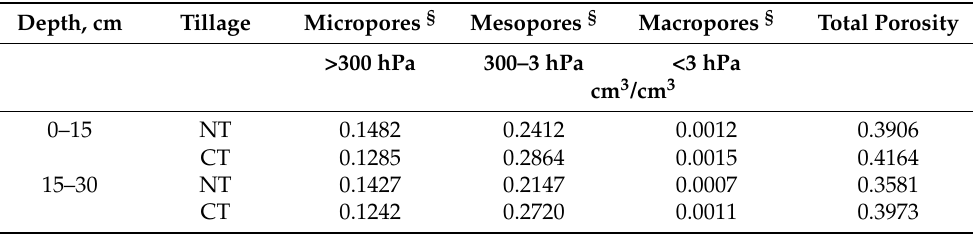
Table 3. Soil pore volume of macro-, meso-, and micro-pore classes of untilled (NT) and convention- ally tilled (CT) soils at 0–15 and 15–30 cm depths. Depth, cm Tillage Micropores § Mesopores § Macropores § Total Porosity >300 hPa 300–3 hPa <3 hPa cm 3 /cm 3 0–15 NT 0.1482 CT NT 0.1427 CT 0.1242 0.0011